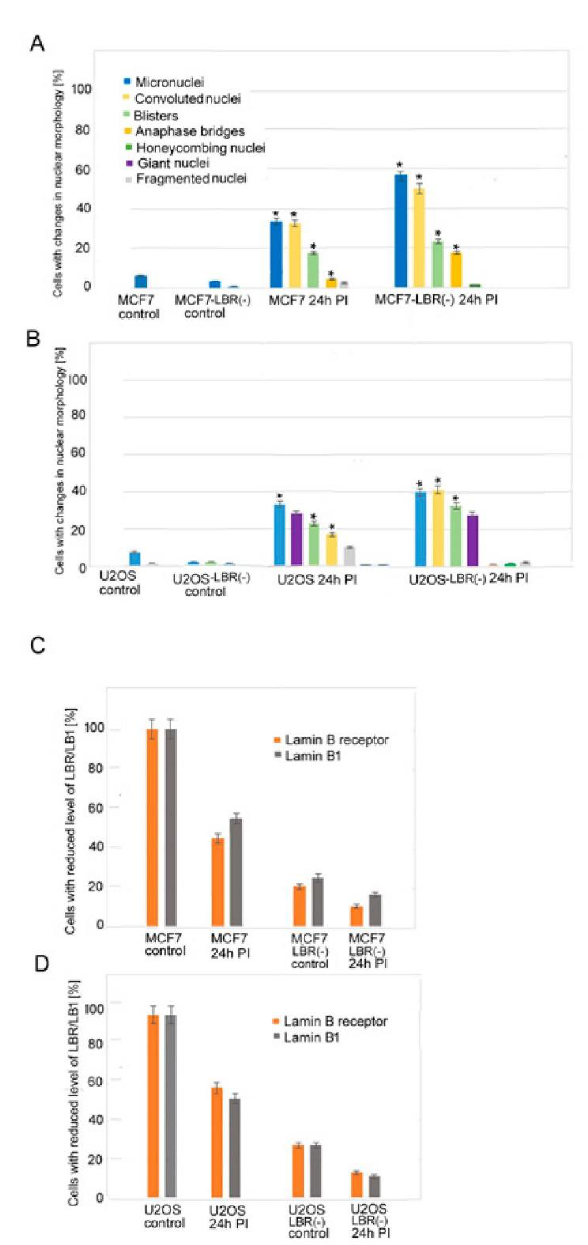
Figure 1. Graphical presentation of changes in nuclear morphology after the irradiation of cells with 8 Gy of γ-rays ( A , B ). Levels of LBR and LB1 in original cell lines and LBR(-) cells stably expressing LBR-specific shRNA (LBR-deficient clones) ( C , D ). ( A ) Defects in original MCF7 and LBR(-) cells. ( B ) Defects in original U2OS cell line and LBR(-) cells. ( C ) Reduction of LBR and LB1 levels in MCF7 cell line and LBR(-)-cells. ( D ) Reduction of LBR and LB1 levels in U2OS cell line and LBR(-)cells. The data were collected from 3 independent experiments. More than 100 cells were counted in each group. The results represent a percentage of the mean number of cells ± SE. There are significant (student t- test, p ≤ 0.05, asterisks) differences in the incidence of most defects between LBR(-) and original cell lines calculated for the comparison of MCF7-LBR(-) with the MCF7 cell line in incidence of micronuclei (MN), convoluted cells, cells with blisters, and cells with anaphase bridges. For comparison of U2OS-LBR(-) with the U2OS cell line, significant ( p ≤ 0.05) difference were found in the incidence of MN, convoluted cells, and number of cells with blisters .